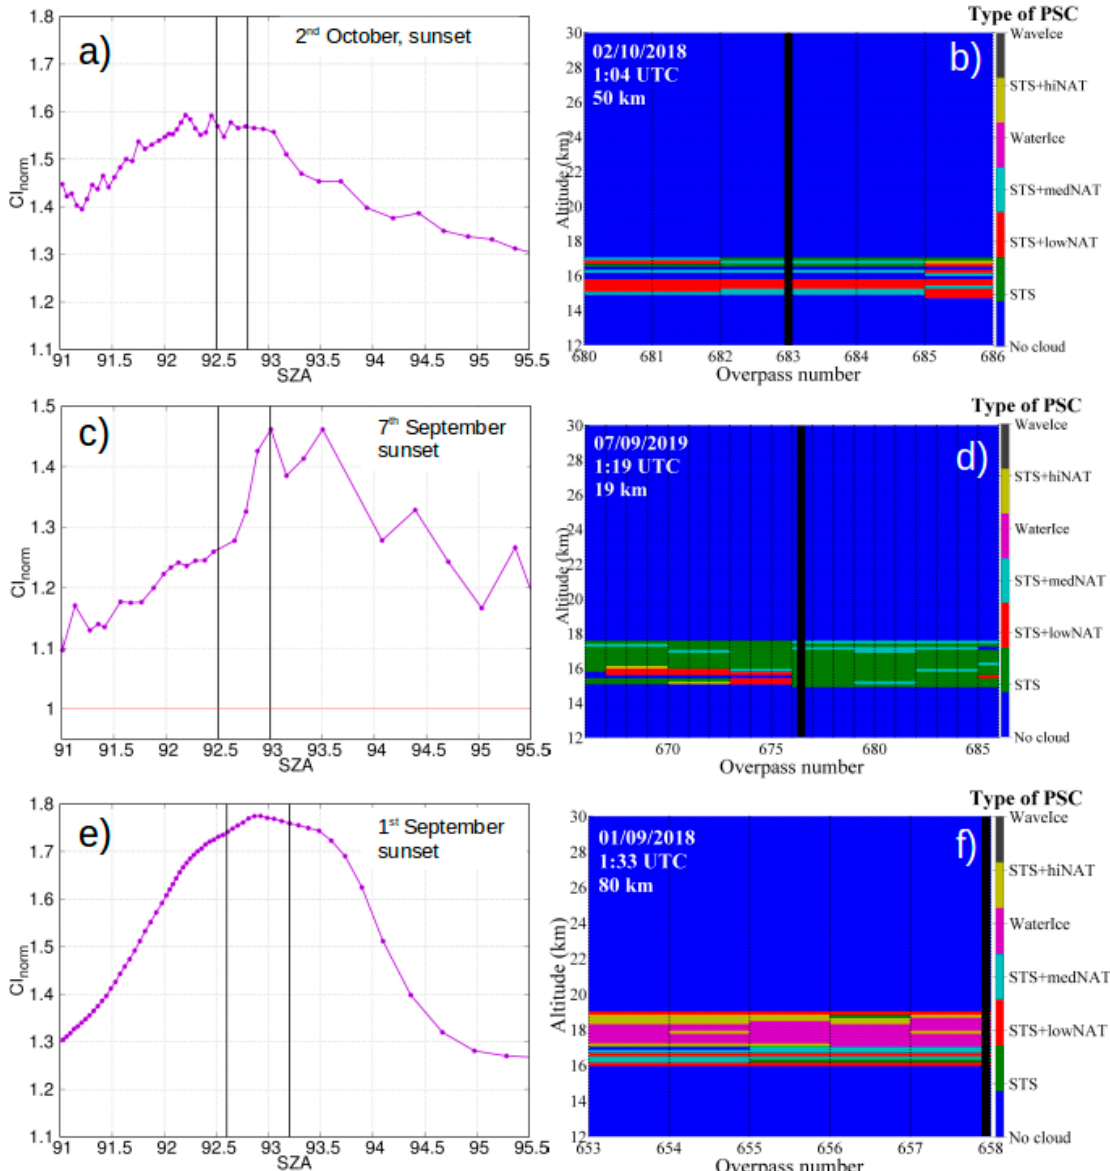
Figure 12. CI norm evolution vs. SZA obtained from our ground-based Vis spectrometer (left figures: a , c , e ) and by Cloud- Aerosol-Lidar and Infrared Pathfinder Satellite Observations (CALIPSO) (right figures: b , d , f ). The upper figures ( a , b ) correspond to observations performed on the sunset of 2 October 2018; the figures in the middle to observations performed on 7 September 2019; and the lower figures ( e , f ) to those on 1 September 2018. The color code of the CALIPSO figures correspond to the different types of PSCs as described in Section 2.2.